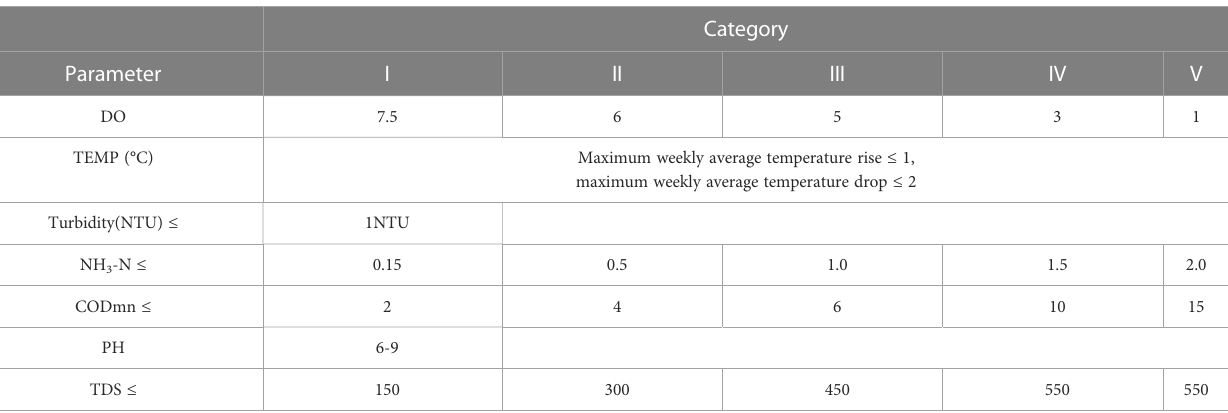
TABLE 2 Environmental quality standard limits for surface WaterRiver water quality data